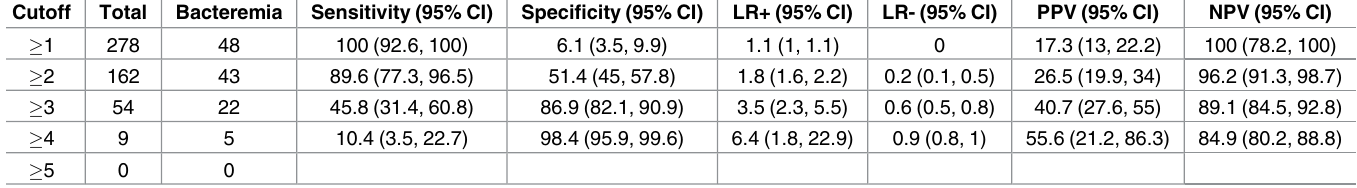
The internal validity of the CPR was verified in the participants extracted via the bootstrap method. The area under the ROC curve (AUC) of the CPR was 0.76 (95% confidence interval [CI]: 0.69, 0.82). Table 4. Assessment of test performance.